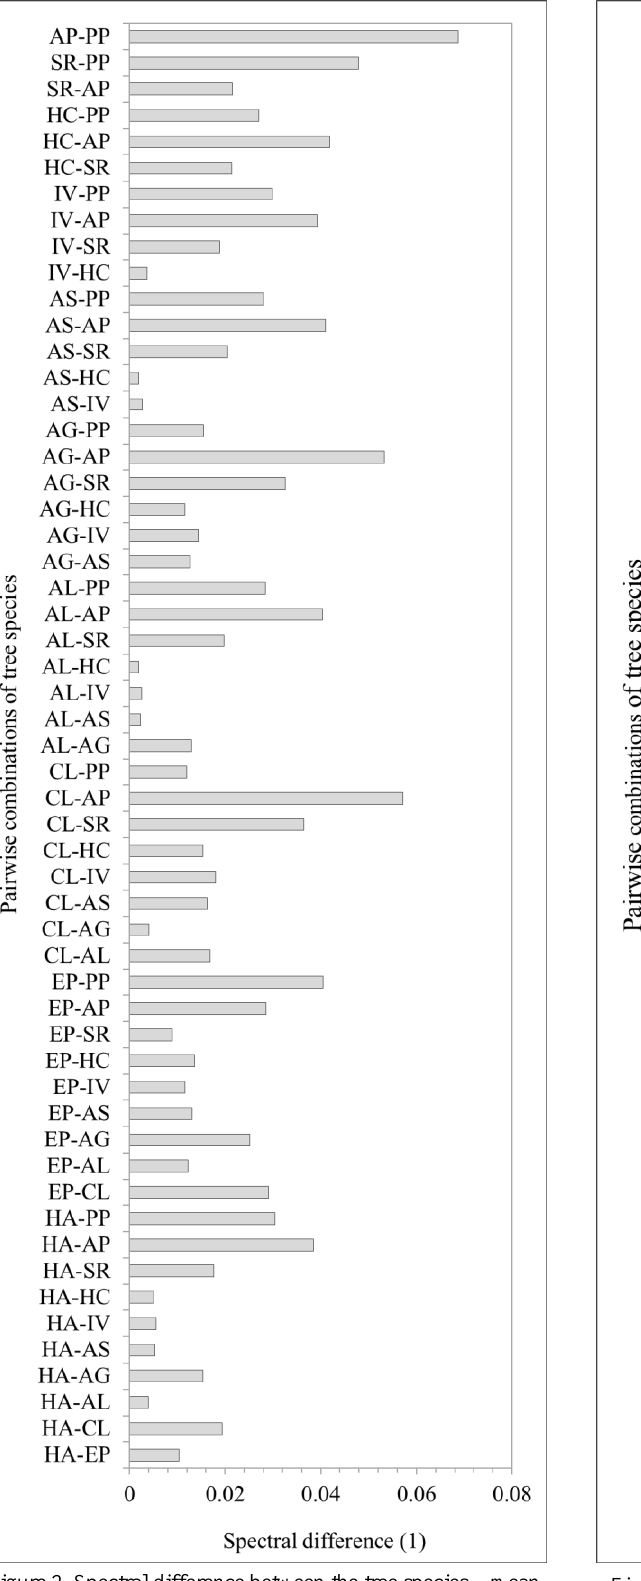
Figure 3. Spectral difference between the tree species – mean normalized features. The y-axis represents the tree species pairwise